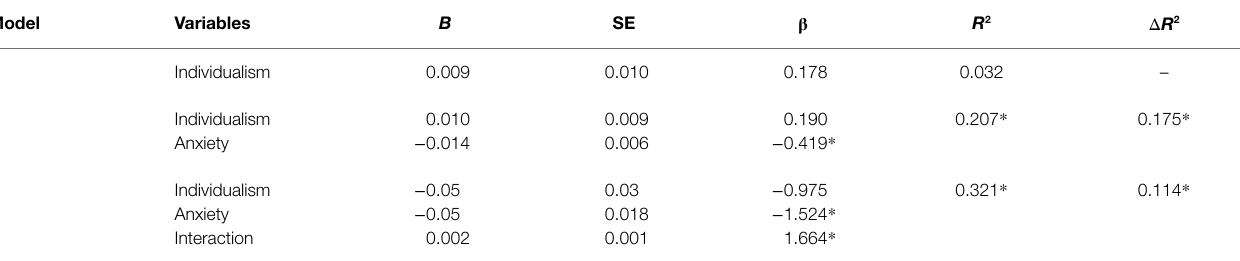
TABLE 2 | Hierarchical linear regression on metacognitive efficiency with individualism, self-reported anxiety and their interaction as predictors.